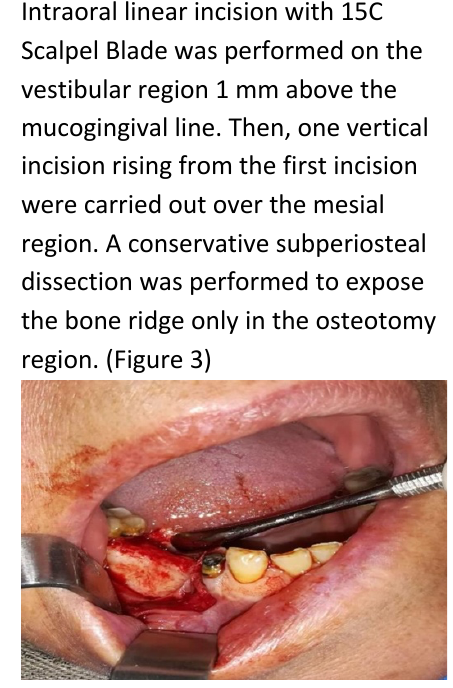
Figure 3. The triangle